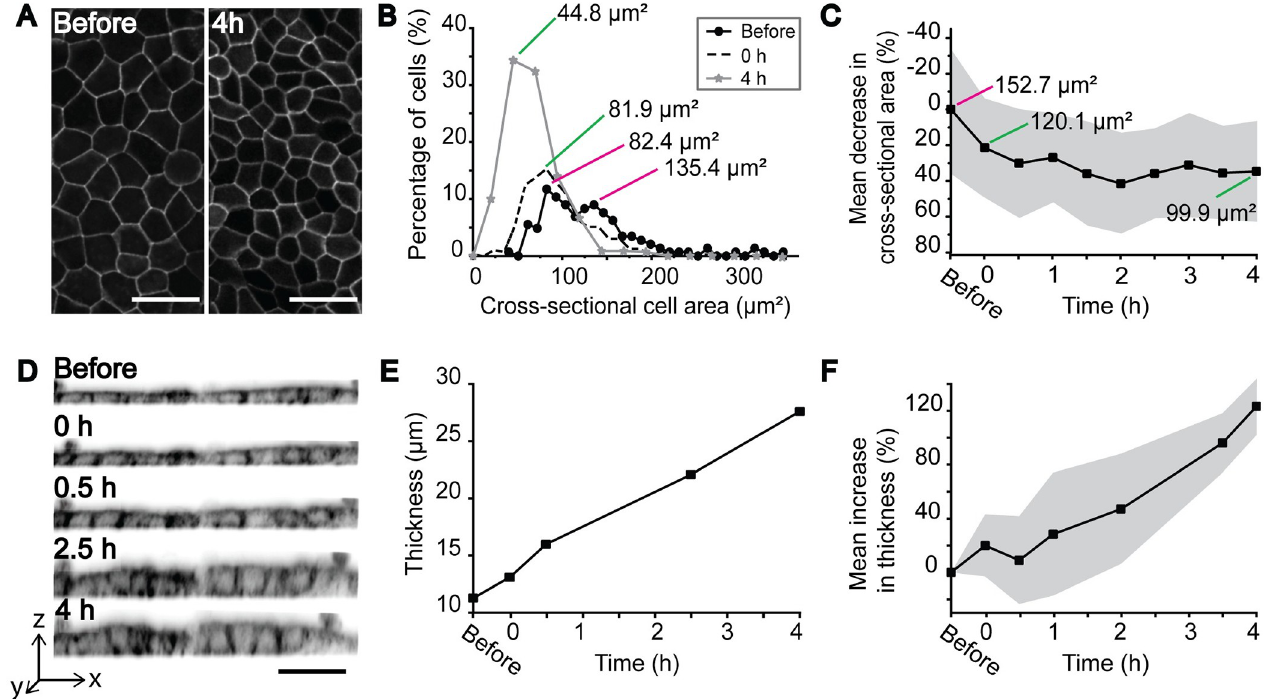
Fig 4. Morphological changes caused by the lateral compression. (A) Maximum intensity projections of occludin-mEmerald expressing MDCK II cells growing on the device, imaged before and 4 h after compression. Scale bar 30 μ m. (B) Example case of the distribution of cell cross-sectional areas before compression, directly after compression and 4 h after compression. Before compression two populations with differing cell cross-sectional areas (marked with magenta lines) are clearly distinguishable. After compression, the distributions are more uniform, indicating of a more homogenous population, and cross- sectional area is smaller (green lines). (C) Mean and SD (grey area) of the decrease in cross-sectional area as a function of time (n = 4). (D) Orthogonal projections of the actin chromobody-mCherry expressing MCDK II cell layer at different time points showing packing and thickening of the cells (scale bar 30 μ m, inverted gray scale LUT), and (E) corresponding cell layer thicknesses during compression. (F) Relative increase in cell layer thickness together with its SD (grey area) as a function of time (n =